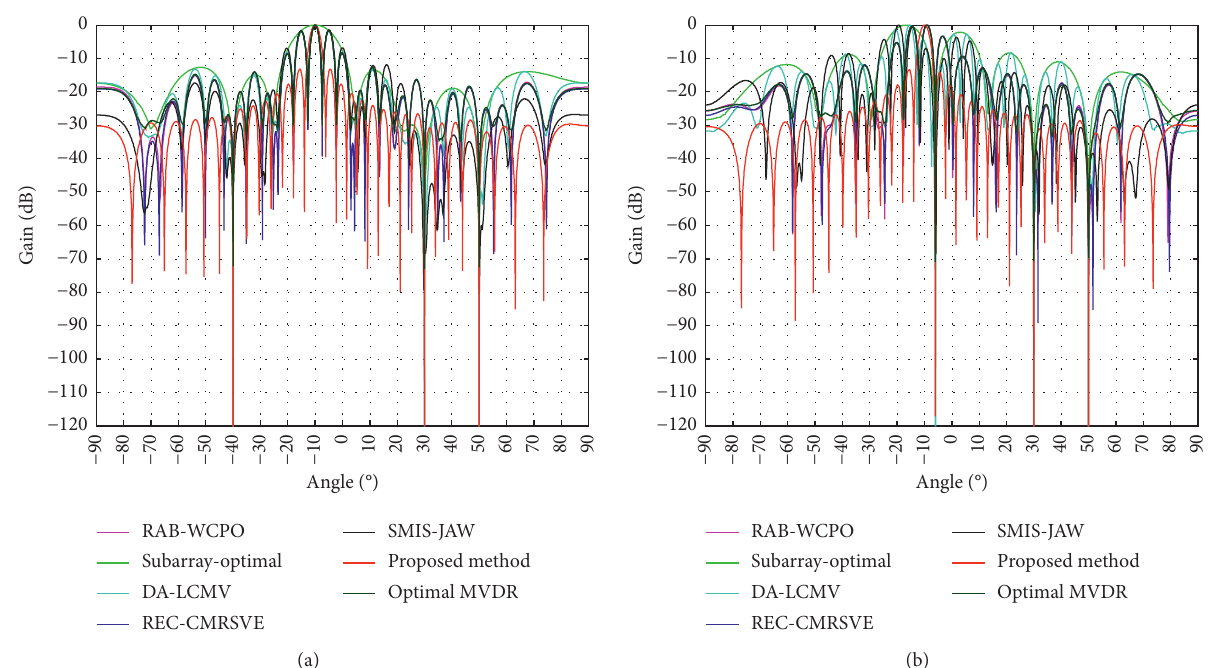
Figure 4: First example: (a) beampattern in the case of sidelobe interferences and (b) beampattern in the case of mainlobe and sidelobe